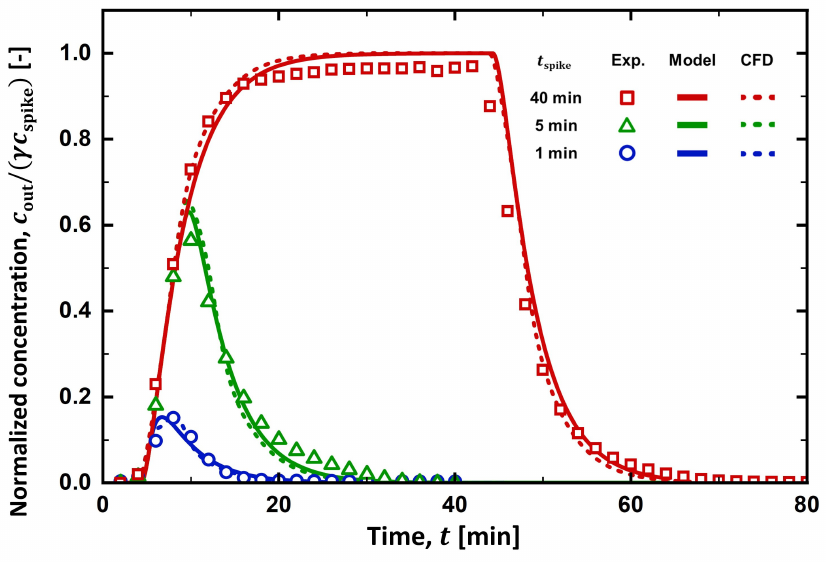
Figure 10. The RTD curves from the CFD simulation compared to those from the experiments and the PFR-2CSTR